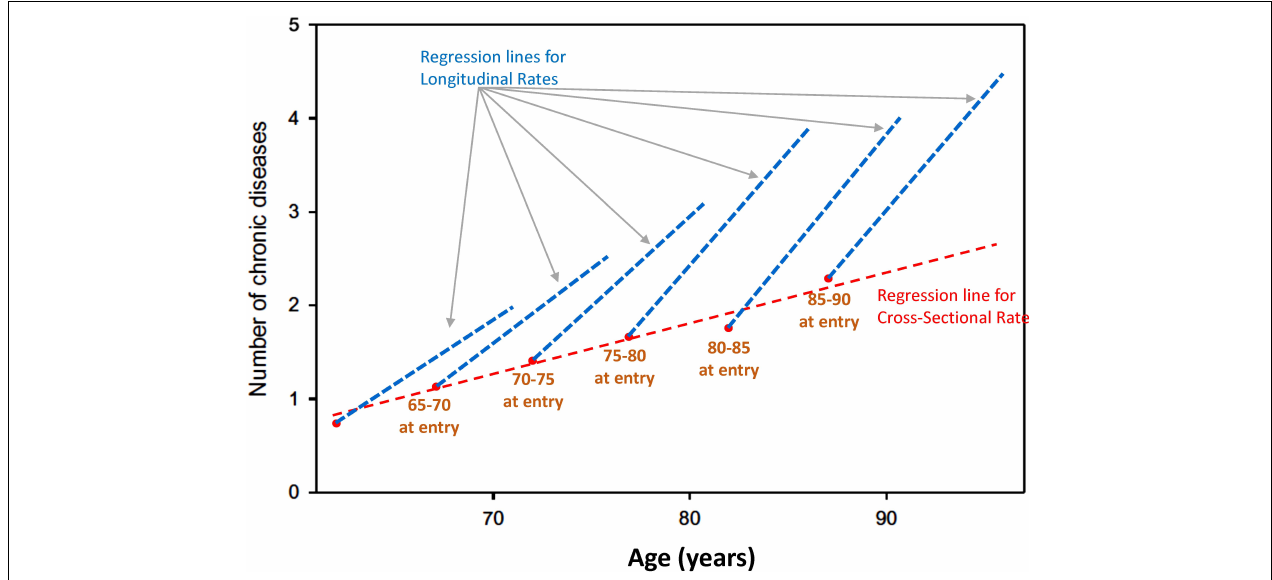
FIGURE 2 | Age effects from cross-sectional studies are affected by selective attrition or loss to follow-up. Data from the BLSA show the relationship between age and multimorbidity. Estimates from longitudinal data in each cohort are much steeper than estimates obtained from baseline data only. In general, because mortality is more likely to occur at older ages, correlations with age may be attenuated because participants whose values are at the extreme of a distribution disappear from the population, and their hypothetical data are not observed ( Figure 1 ).